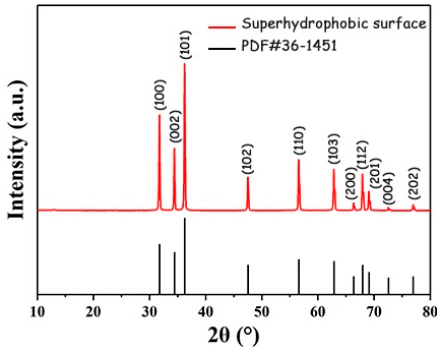
Figure 5. X-ray diffraction (XRD) pattern of the prepared sample.